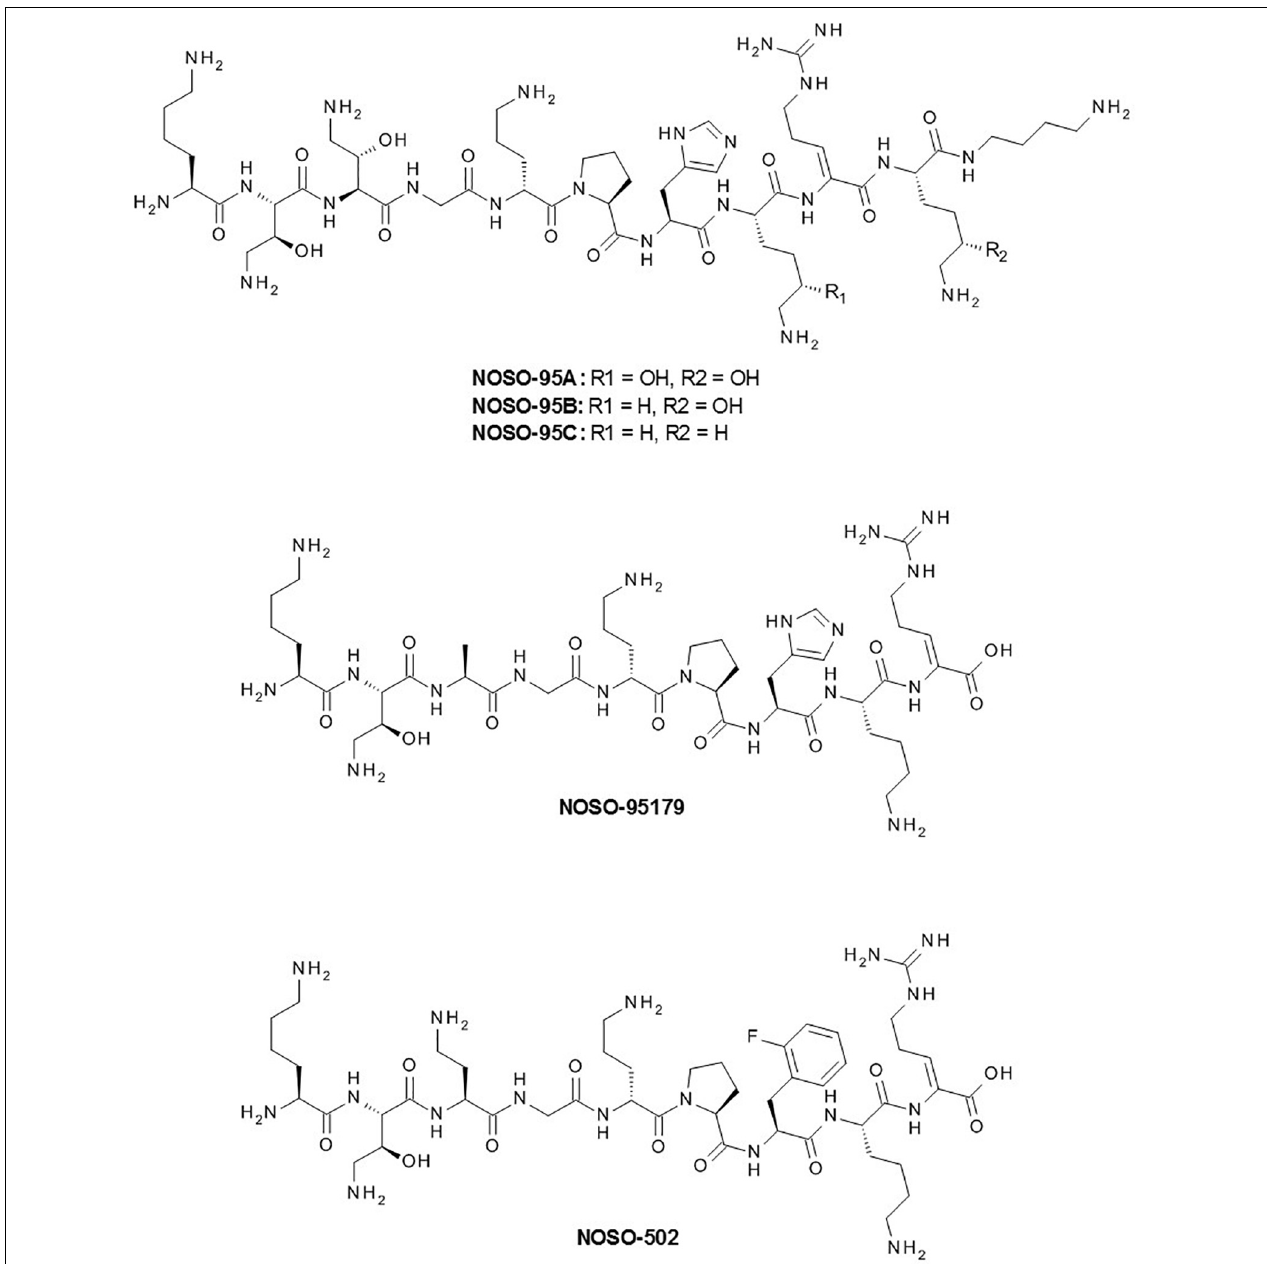
FIGURE 2 | Chemical structures of NOSO-95A, B, and C, NOSO-95179 and